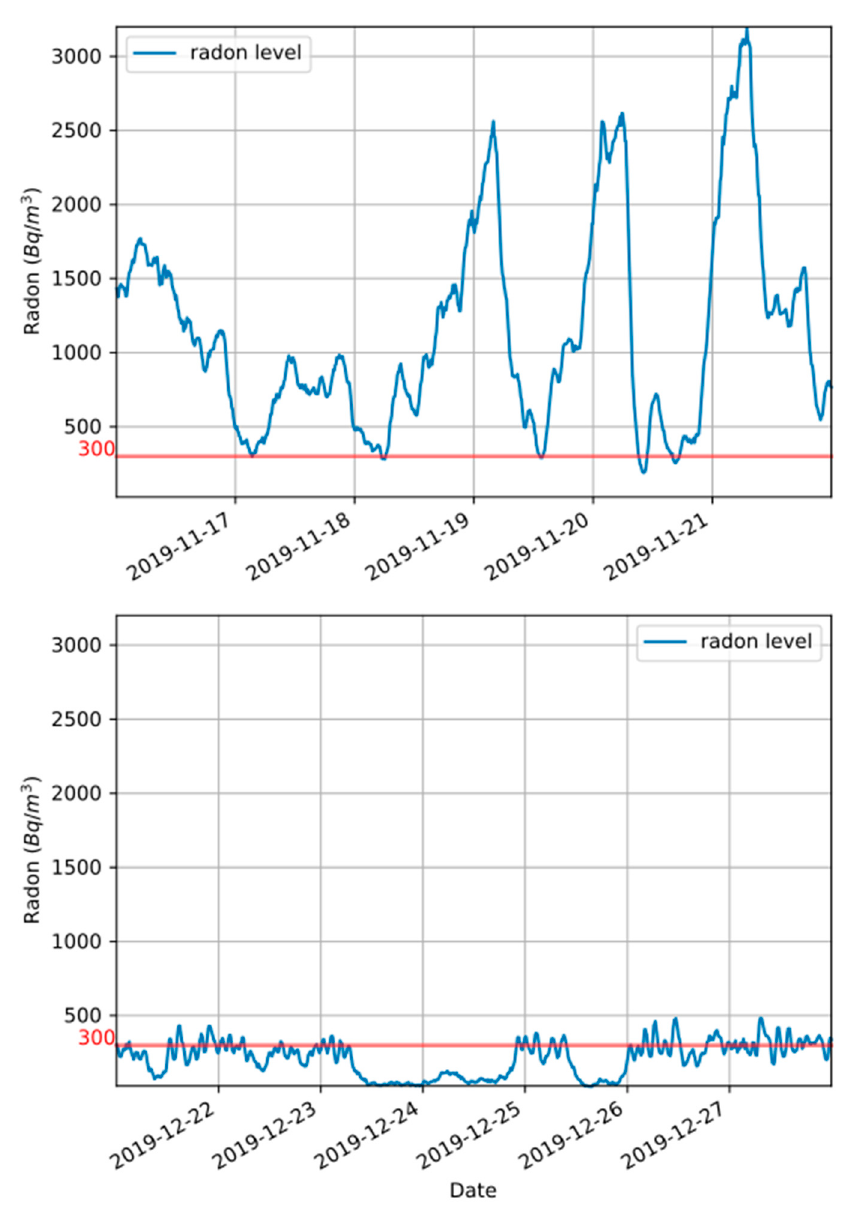
Figure 10. Radon levels for the same location. Up: alert system activated. Down: alert system activated and air flow control system operated by human.